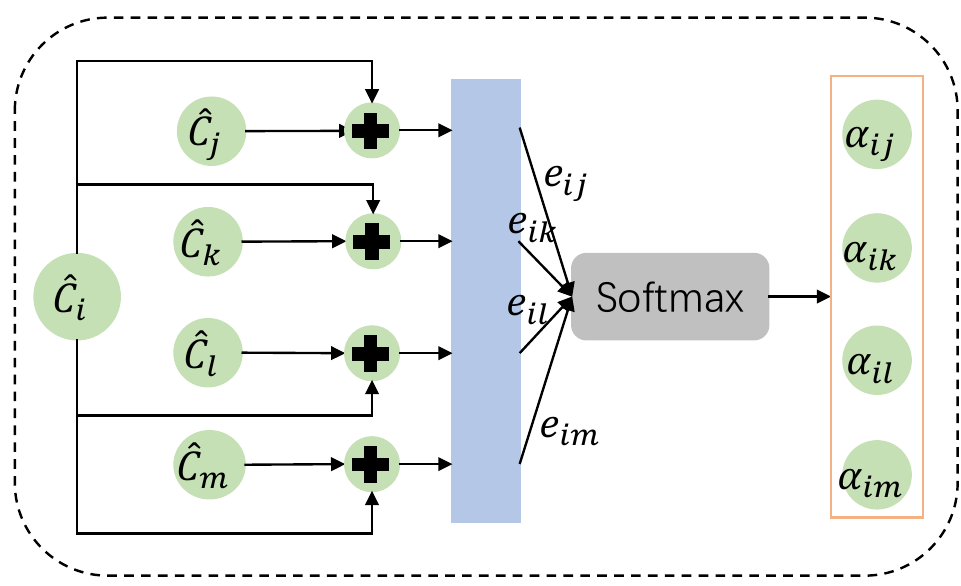
Figure 4. Architecture of attention. Different states of neighbors of agent i ( (cid:98) C j , (cid:99) C k , (cid:98) C l , (cid:99) C m ) are concentrated with agent i ; then, the attention coefficient e ij is calculated. The normalized form of e ij is α ij , and it is used as the weight of state